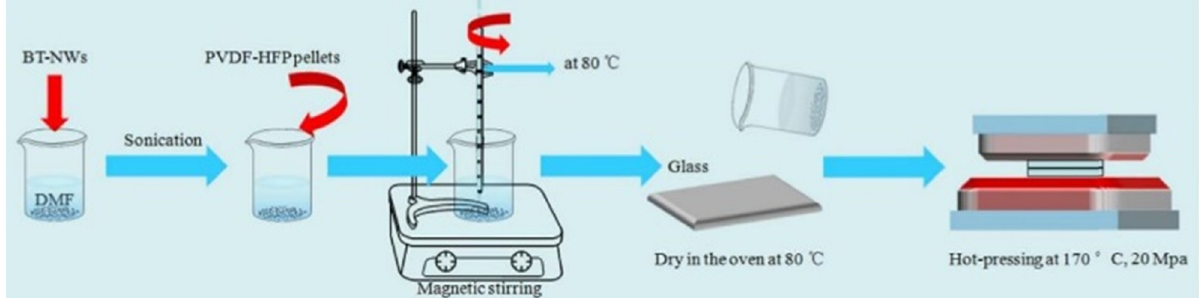
Figure 9: The hot press process for fabrication of PVDF - HFP/BT - NW composites [ 62 ] .